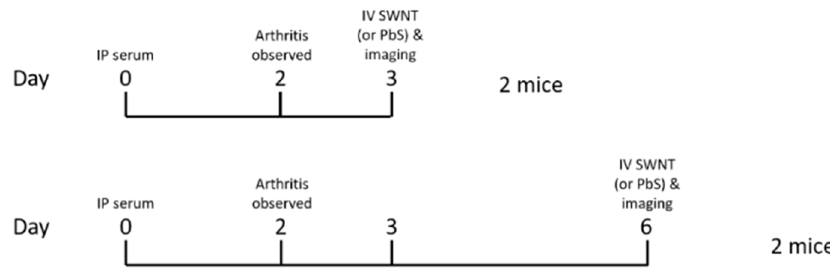
Figure 1. In vivo study—overview of procedures.